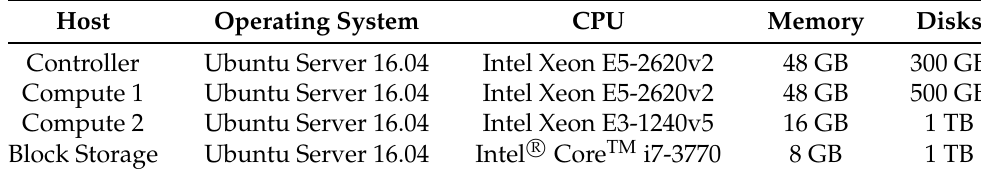
Figure 5. Architecture diagram of the experimental environment. Table 6. Specification table of the hosts in the system to be